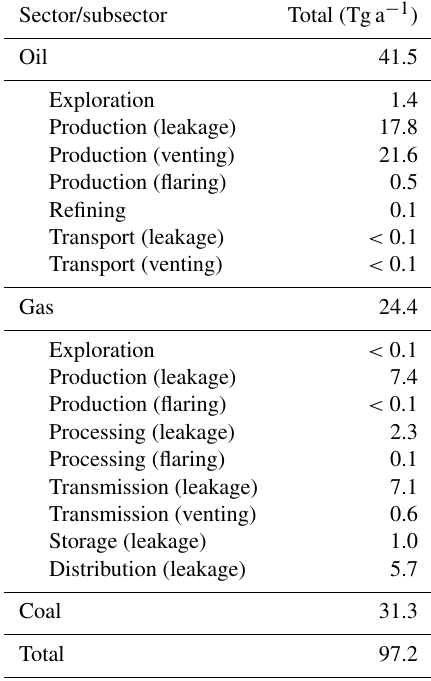
Table 2. Global methane emissions from oil, gas, and coal in 2016 ∗